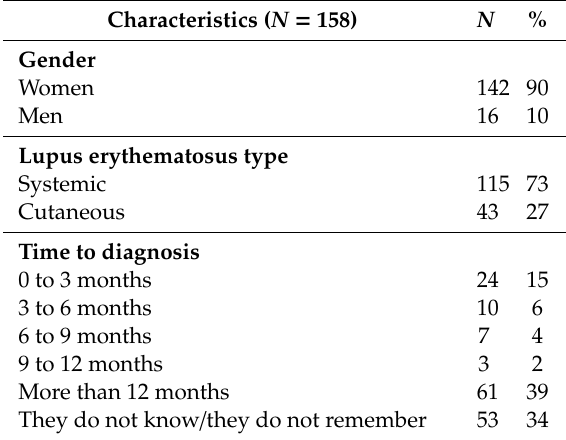
Table 1. Characteristics of the final